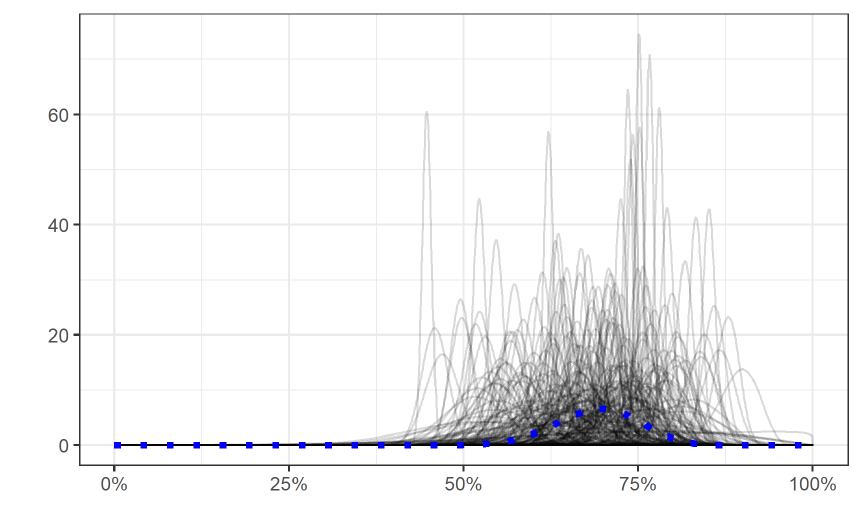
Figure 3. This plot shows 250 samples from the prior in black. The dotted blue line shows the prior using the values obtained from Part 1